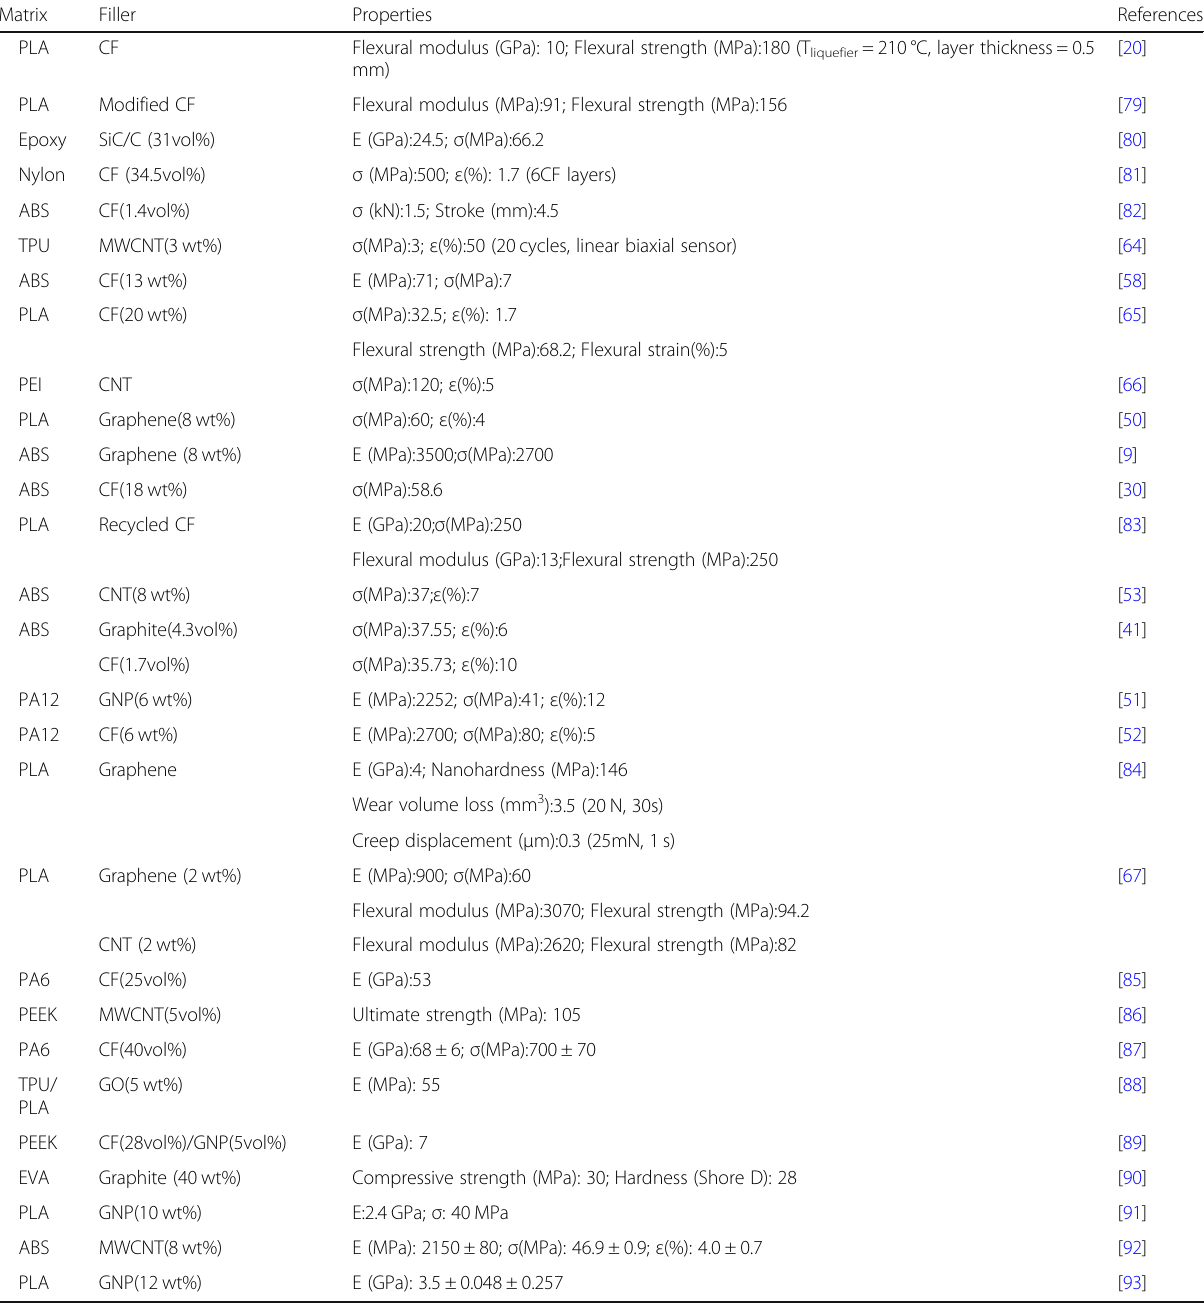
Table 1 Main properties of composites of polymers with carbonaceous additives prepared by FDM as reported in literature. a